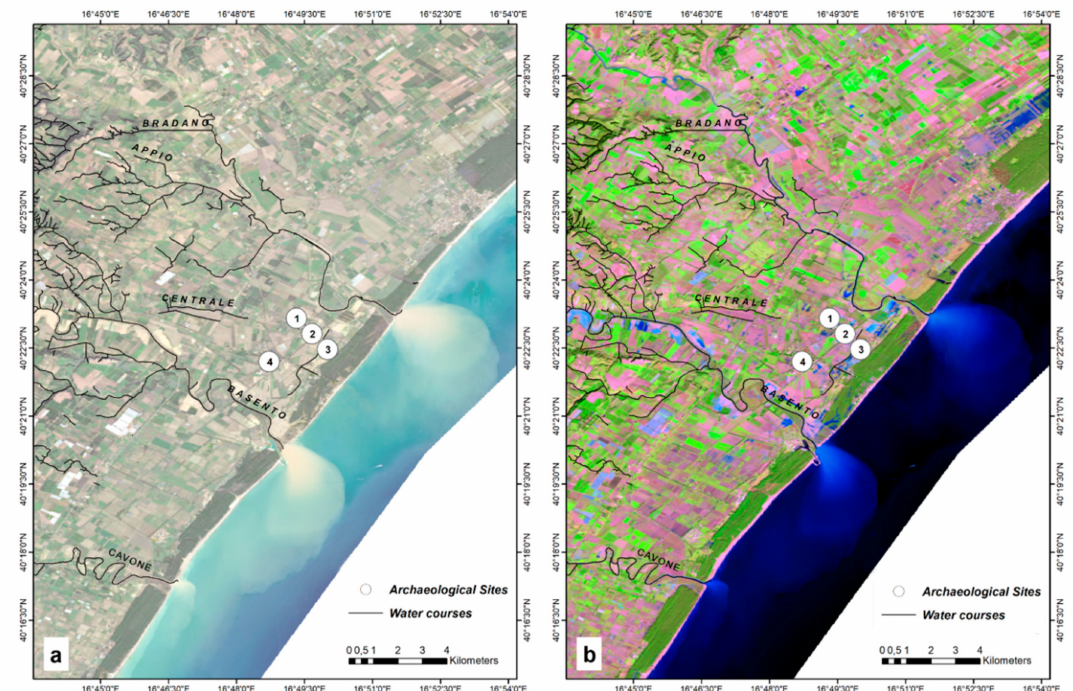
Figure 7. Localization of the region of interest. In the background, the ( a ) natural color (Red = Band 4; Green = Band 3; Blue = Band 2) and ( b ) vegetation analysis (Red = Band 6; Green = Band 5; Blue = Band 4) of Landsat 8 C2 L2 Imagery data acquired on 6 December 2013. Archaeological Sites: 1. Metaponto excavation; 2. Castrum; 3. Ancient remains; 4. Castello Torremare. Figure 8 represents the raster maps of the Landsat 8 NDVI, MNDWI, and NDWI2 indices for the study area relating to the December 2013 flood as generated by GEE code.